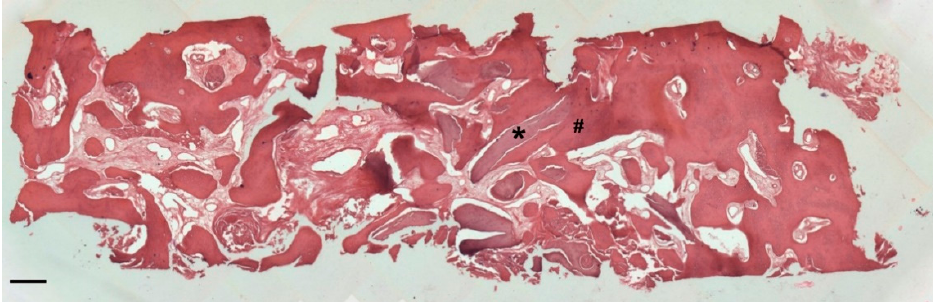
Figure 10. Cone-beam computed tomography (CBCT) shows bone volume preservation in the distal surface of the alveolus.